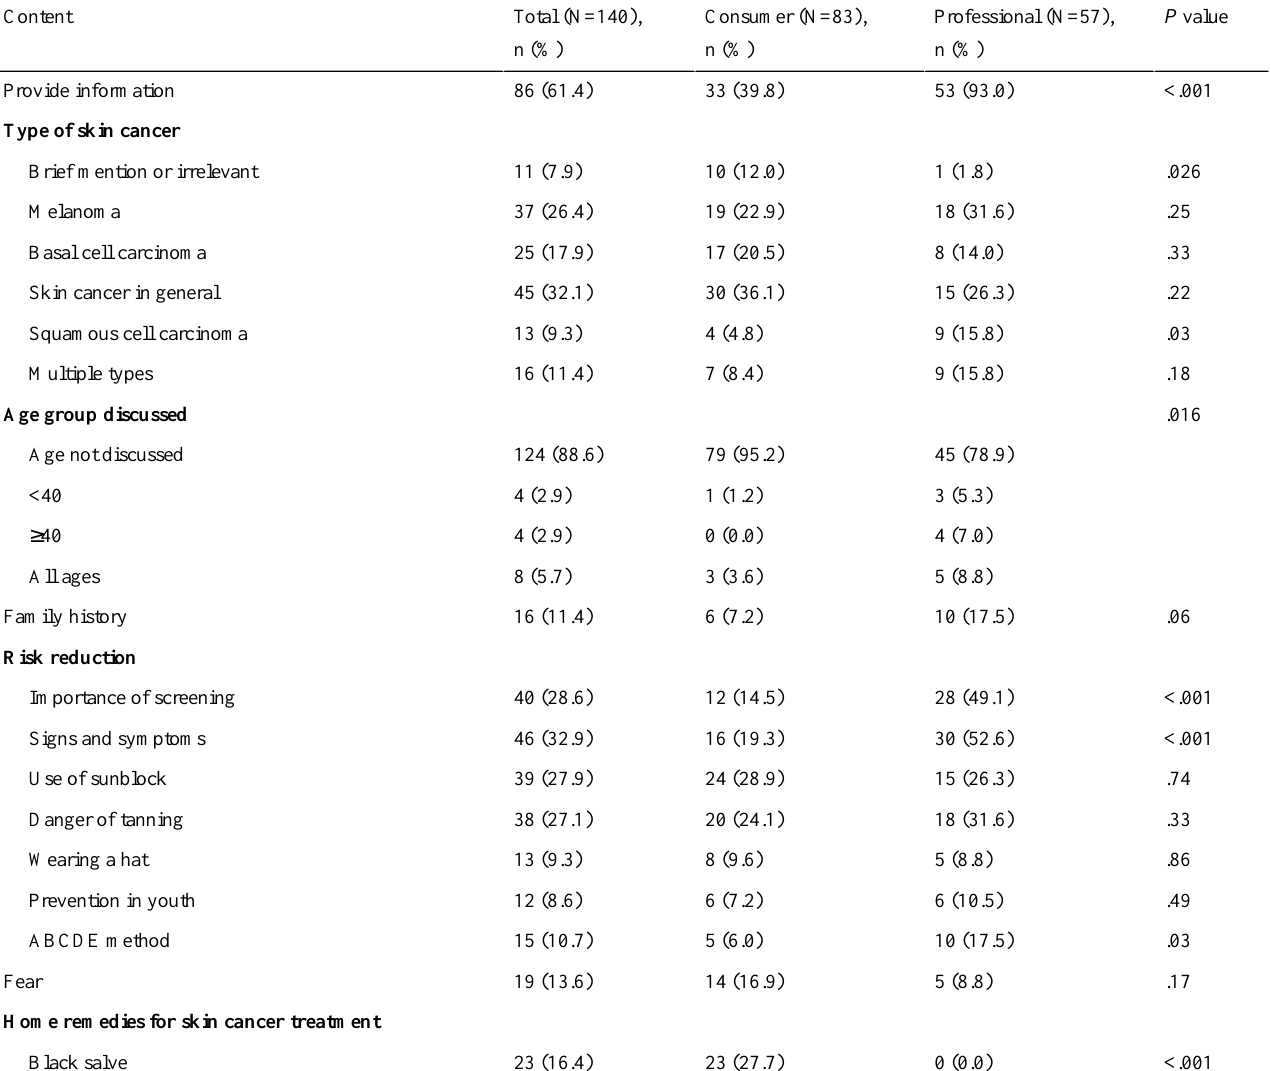
Table 2. Content of 140 popular skin cancer screening videos posted on YouTube.